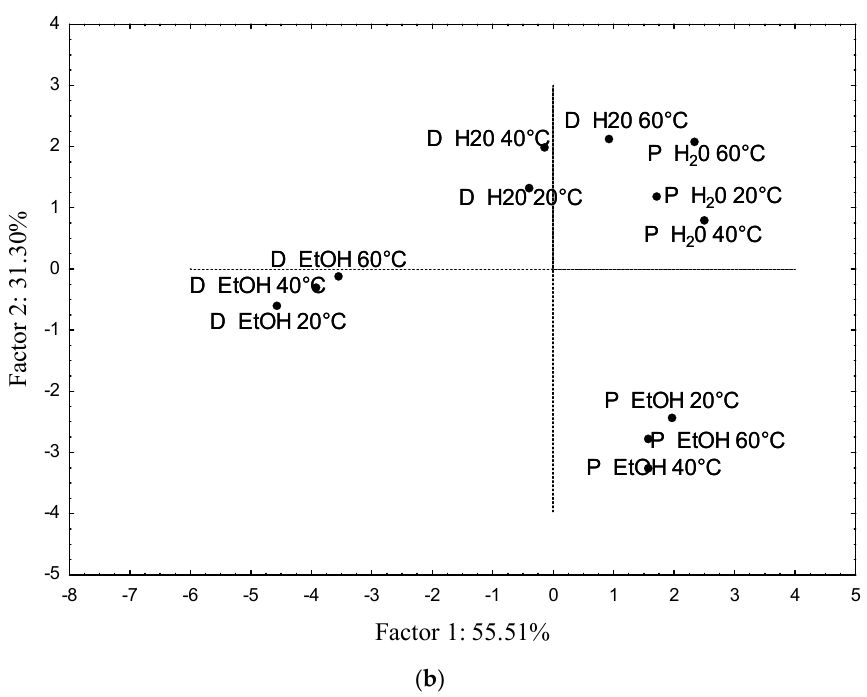
Figure 2. Correlation of the ( a ) loading plot and ( b ) score plot of the PCA. The obtained results from the PCA are in accordance with the Pearson product moment correlations between variables that showed a high correlation between total phenolics and both FRAP ( r = 0.8005, p = 0.0018) and ORAC values ( r = 0.9483, p < 0.001), FRAP and phlorotannin content ( r = 0.8951, p = 0.001), flavonoids and tannins ( r = 0.9744, p < 0.001), flavonoids and reducing activity ( r = 0.9739, p < 0.001) and DPPH and ORAC ( r = 0.8033, p =